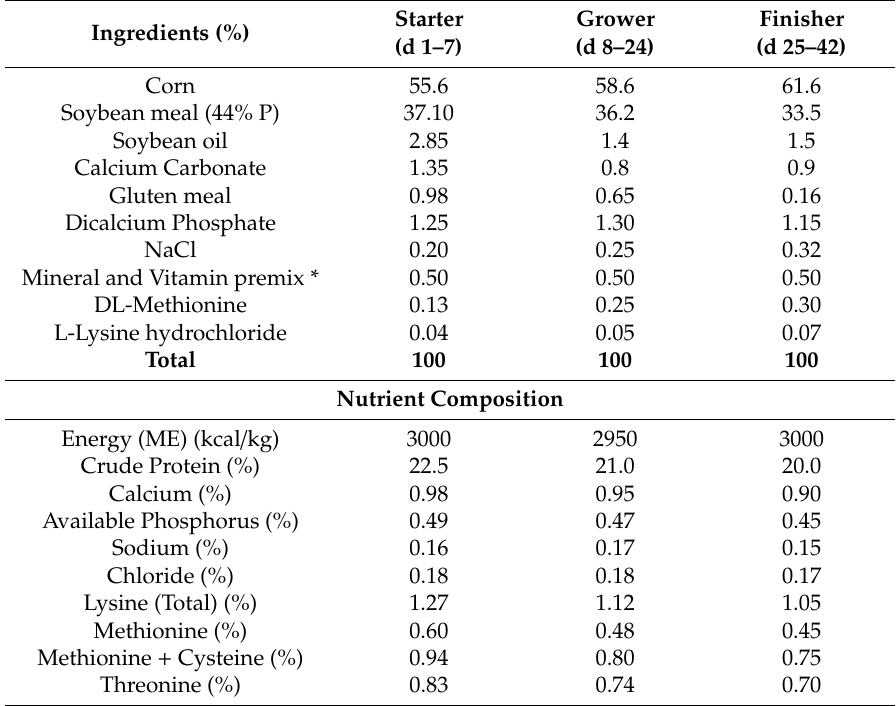
Table 1. Feed ingredients and nutrient content of the starter (day 1–14), grower (day 15–28), and finisher (day 29–42)